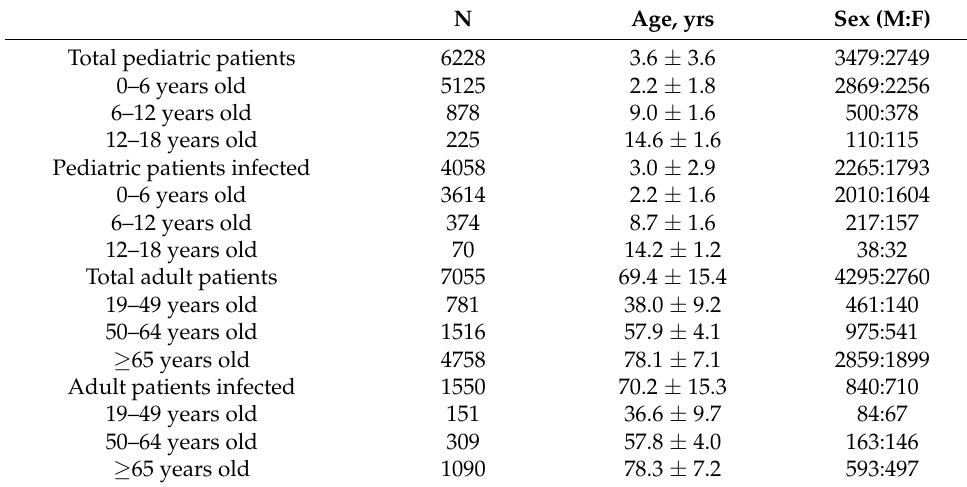
Table 1. Demographic characteristics.